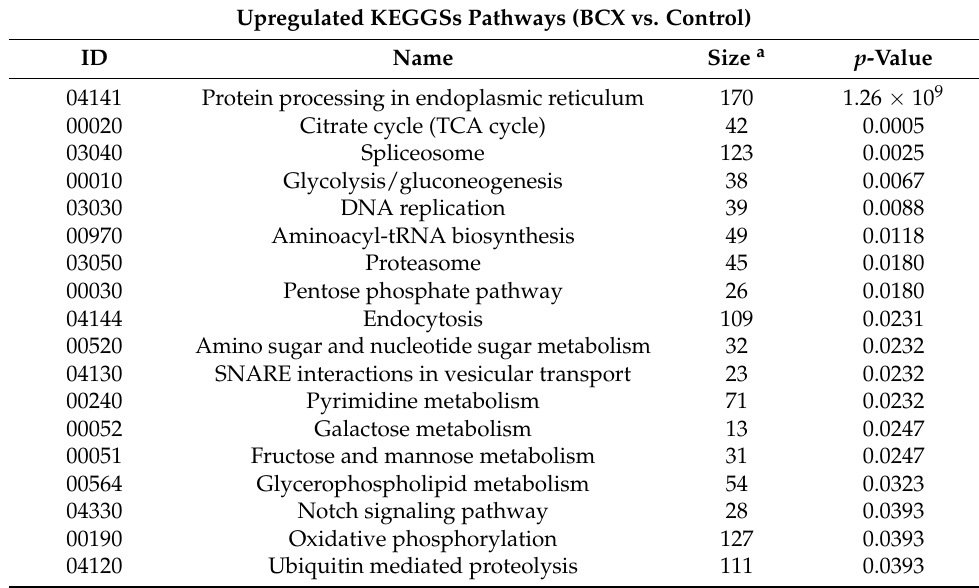
Table 2. KEGG (metabolic pathways were significantly ( p ≤ 0.05) upregulated in C. elegans N2 after feeding with β -Cryptoxanthin (BCX) (0.025 µ g/mL) as compared with control feeding conditions. Upregulated KEGGSs Pathways (BCX vs.